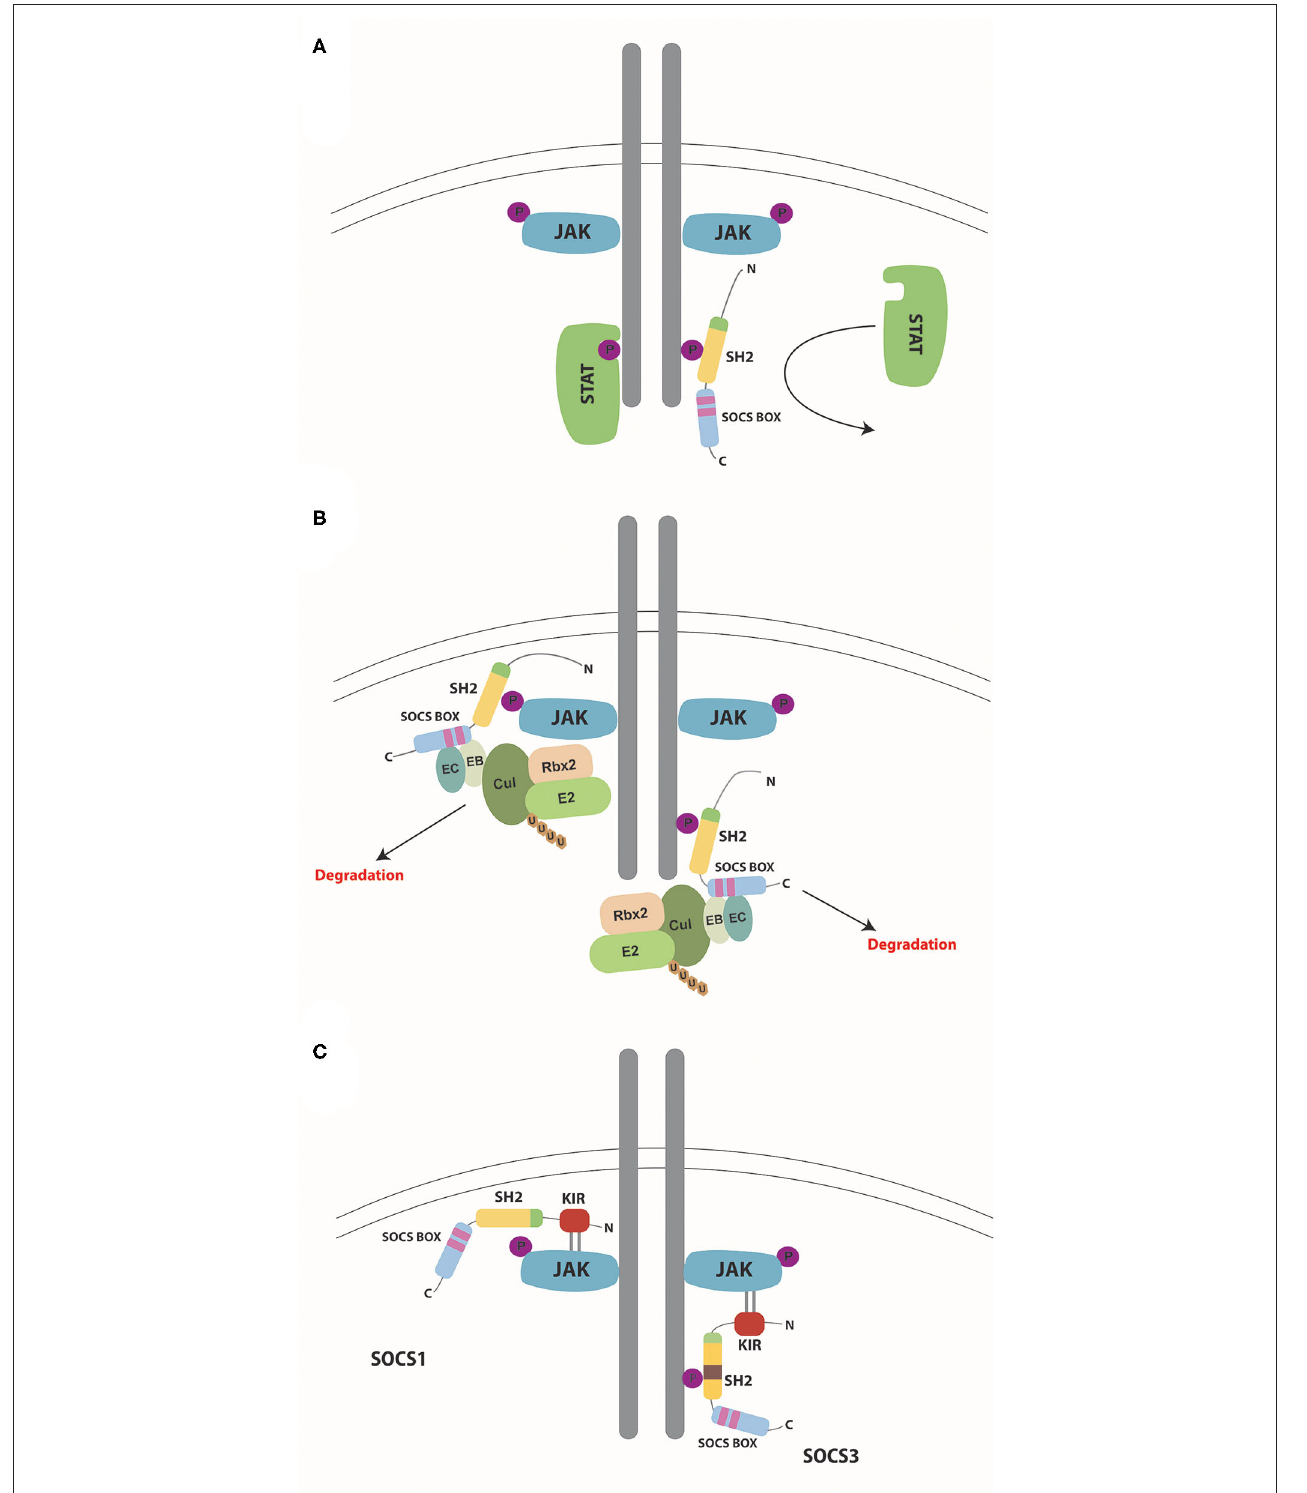
FIGURE 3 | Mechanisms of SOCS action. Schematic representation of the mechanisms by which SOCS proteins negatively regulate cytokine receptor signaling via the JAK/STAT pathway. (A) Competitive binding. SOCS proteins bind to phosphorylated tyrosine residues on the cytokine receptor via their SH2 domain, thereby preventing docking of STAT (and other) proteins and so inhibiting their subsequent activation. (B) Degradation. SOCS proteins bind through their SH2 domains to